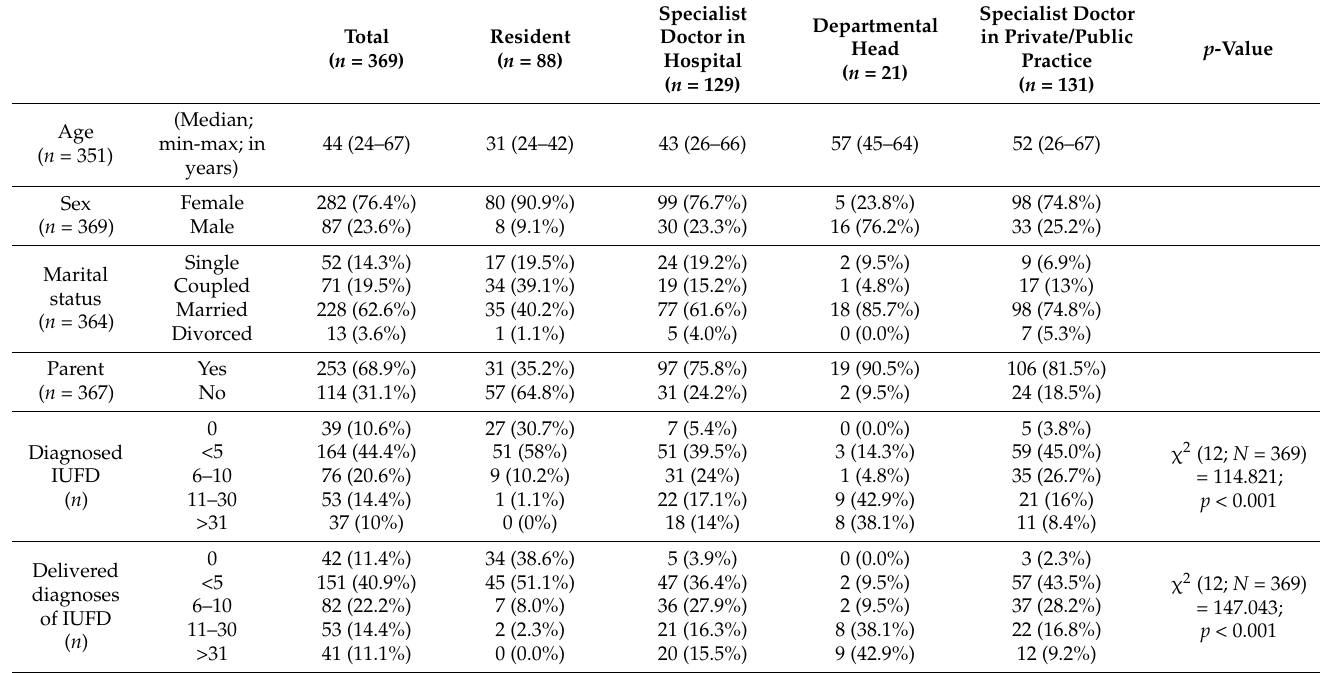
Table 1. Baseline characteristics of obstetricians who participated in the online survey conducted by the Austrian Society of